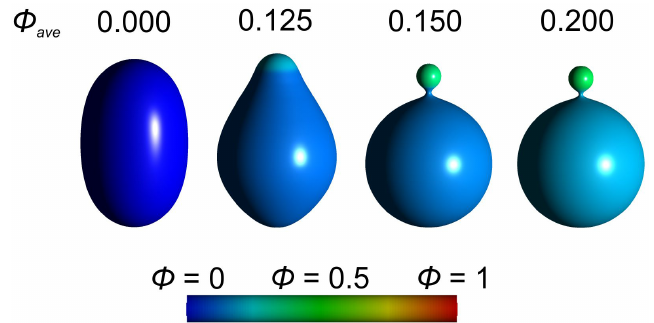
Figure 20. Equilibrium closed membrane shapes calculated for different values of the average relative area density φ ave of highly curved isotropic nanodomains A . Membrane contains two types of flexible isotropic nanodomains denoted by A (highly curved) and B (slightly curved). The average relative area density of nanodomains B is ( 1 − φ ave ) . The red color ( φ = 1) represents the highest possible local relative area density (concentration) of the nanodomains A , while the local concentration of the nanodomains B is given by ( 1 − φ ) . The entropy of mixing was taken into account in minimization of the membrane free energy. Shapes were calculated by minimizing the energy functional given by Equation (49) for the following values of model parameters: v = 0.95 H B m = 1, D B m = 0, H A m = 16, D A m = 0, κ A = 8 κ B , κ B = 30 k B T , R 0 = 250 nm and a 0 = 100 nm 2 . Here, R 0 is the radius of the sphere with the same surface area as the surface of the investigated cell/vesicle. Adapted with permission from ref. [170]. 2020 Public Library of Science.